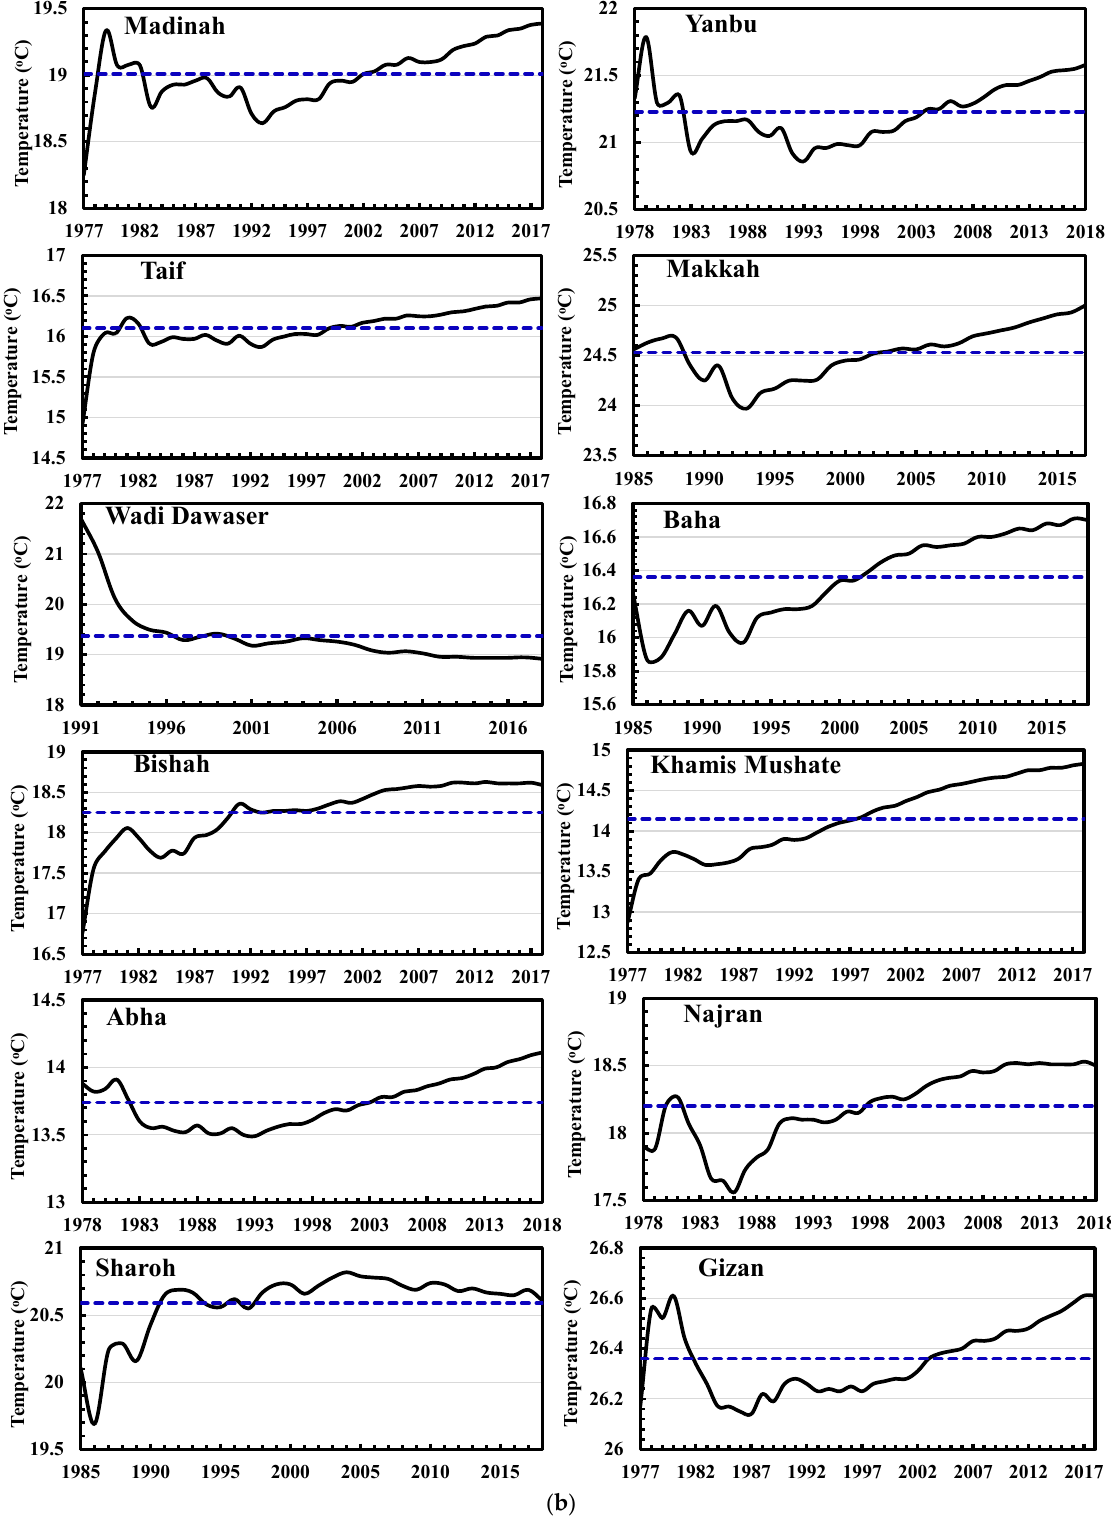
Figure 4. ( a ) The Cumulative Seasonal Means time series and the averaged Cumulative Seasonal Means in Turaif, Guriat, Arar, Aljouf, Rafha, Tabouk, Qaisumah, Hail, Gassim, Wejh, Ahsa and Ri ‐ yadh. ‐‐‐‐‐‐‐‐‐ The means of CSM and the CSM time series. The stations are arranged from north to south. ( b ) As in ( a ) but for the stations Madinha, Yanbu, Taif, Makkah, Wadi Dawaser, Baha, Bishah, Khamis Mushate, Abha, Najran, Sharoh and